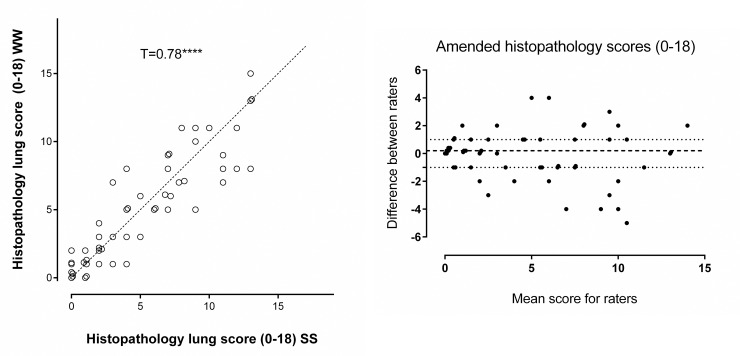
A. Scatter dot plot showing individual pulmonary histopathology scores for lung samples using the modified scoring system (max 18 points) WW vs. SS, Kendall rank order coefficient T = 0.78, z = 8.96, p≤0.00003. NB some similar values that overlapped have been nudged so that the data points can be seen. B. Bland-Altman analysis of the modified scoring system, WW vs. SS, difference (WW-SS) vs. mean. The dotted lines show the Inter Quarter (IQ) range.